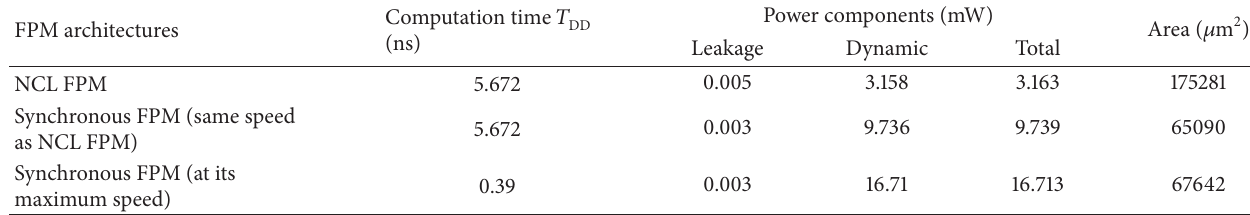
Table 5: Comparison of NCL FPM and synchronous FPM.